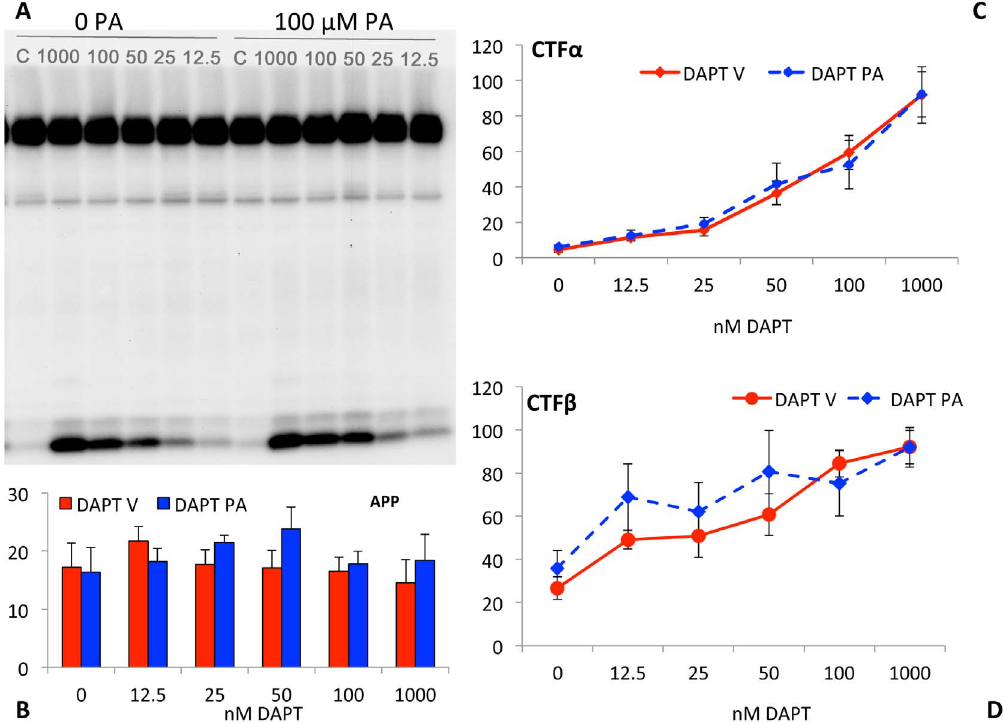
Figure 5. PA treatment does not affect APP processing. SH-SY5Y-APP695 cells were treated with 0 to 1,000 nM DAPT in the absence and presence of 100 m M PA and cell lysates were analyzed as in Fig 3. Panel A is a representative Western blot with O443 showing APP (top band), CTF b (Faint lower band) and CTF a (dark lowest band). The quantified band intensities for APP (B), CTF a (C) and CTF b (D) show the changes observed with DAPT treatment in the presence (blue bar and dotted lines with solid diamonds) or absence of PA (red bars, solid red circles). Note that the labels on the x-axis are not drawn to scale to include the 1000 nM DAPT data. Tukey-Kramer analysis show that there is significant dose-dependent increase in CTF b (p , 0.002) and CTF a (p , 0.0001) with DAPT treatment, but there is no significant change in either CTF b (p . 0.2, 0.5) or CTF a (p . 0.8, 0.9).